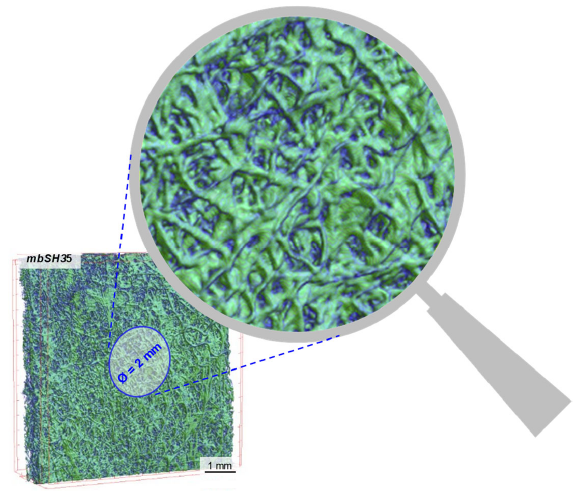
Figure 4. FTIR analysis area (2 ‐ millimeter diameter circle).